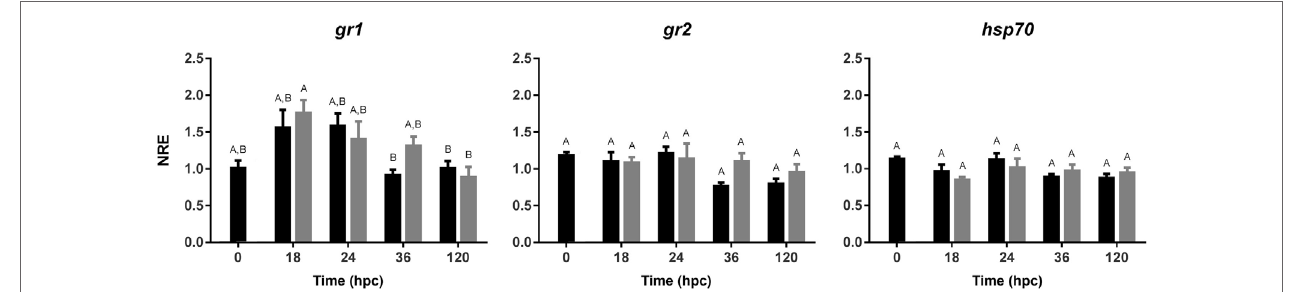
FigUre 4 | Normalized relative expression (NRE) analysis (mean ± SE) of stress-related genes in full-sibling sea bass larvae challenged with Vibrio anguillarum . The expression of glucocorticoid receptor 1 ( gr1 ), gr2 , and heat shock protein 70 ( hsp70 ) was evaluated from whole-single larva ( n = 10 per time point) in each time [hours post-challenge (hpc)] for non-challenged (black bar) and challenged group (gray bar). Significant differences (linear regression model with Tukey correction posttest) are shown by different capital letters (A, B; p <